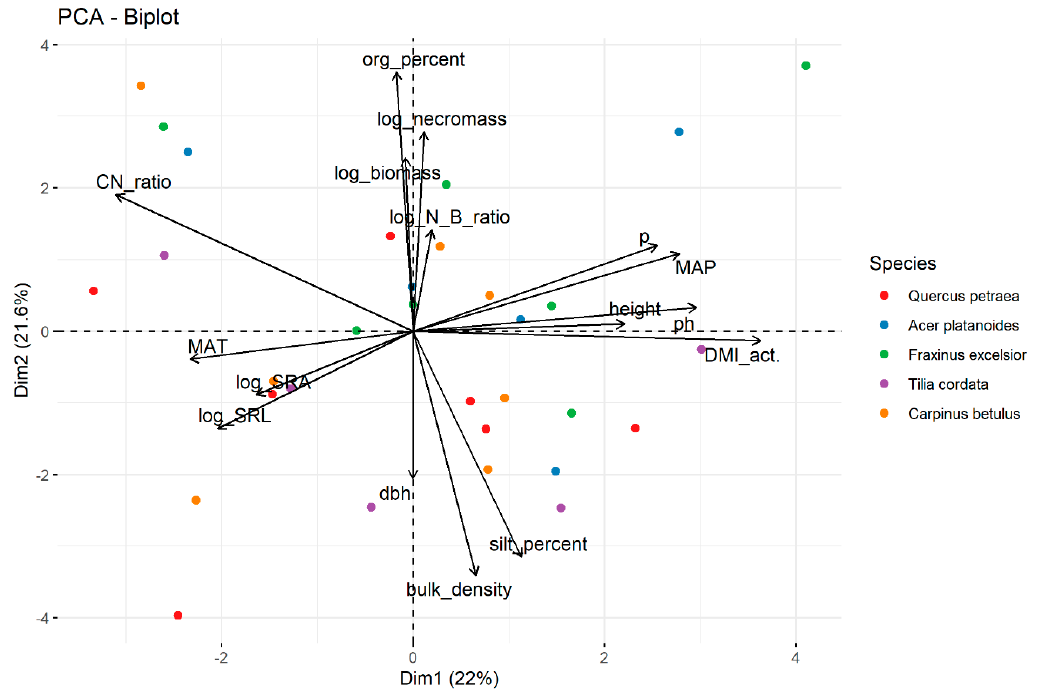
Figure A4. PCA biplot of the 2018 fine root inventory. All data are aggregated on site and species level.